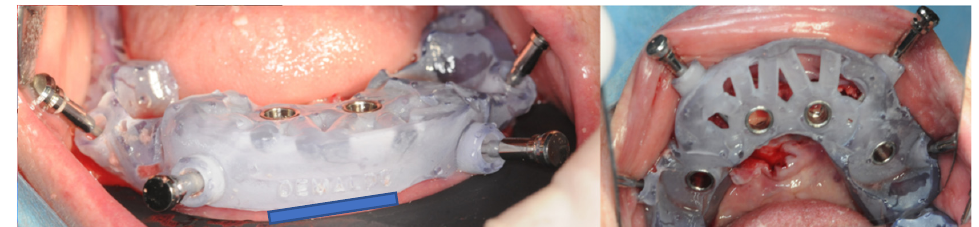
Figure 12. Details of the osteotomy executed with Piezosurgery.